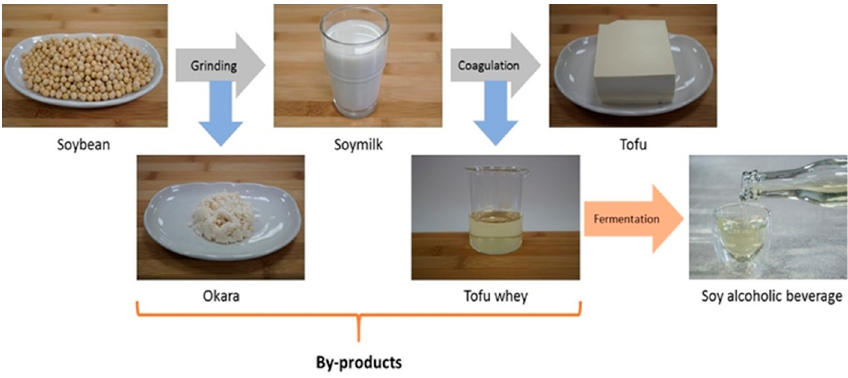
Figure 2. Soybean by-product production.